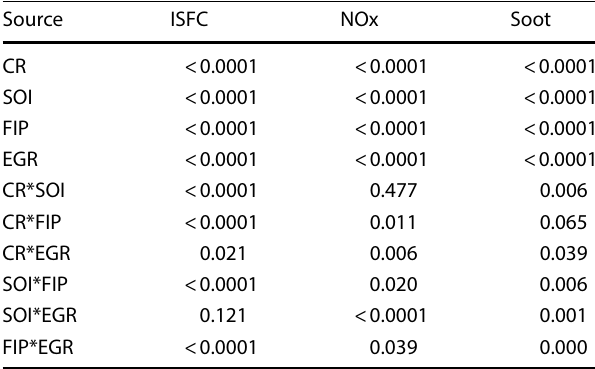
Table 5 p values for model terms of ANOVA analysis